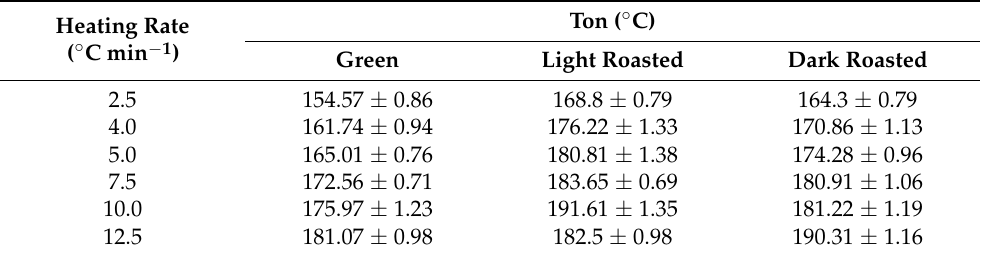
Table 2. Onset oxidation temperatures (T on ) obtained for six sample heating rates during the thermo- oxidative processes. ( ± ) standard deviation (SD) from triplicate measurements.